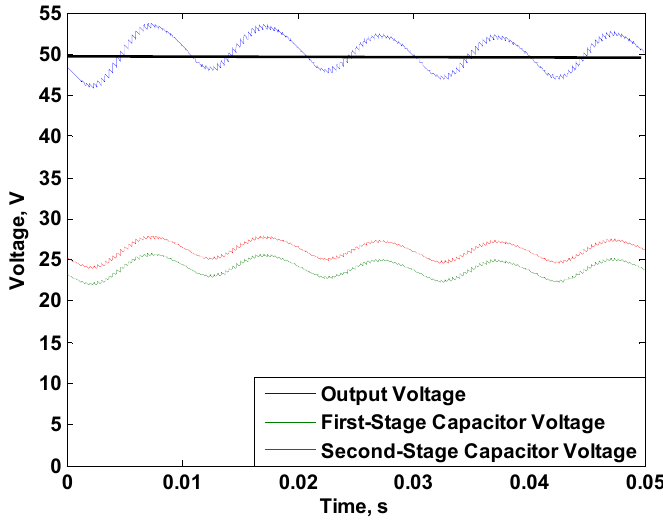
Figure 39. Experimental output voltages considering a closed-loop control.